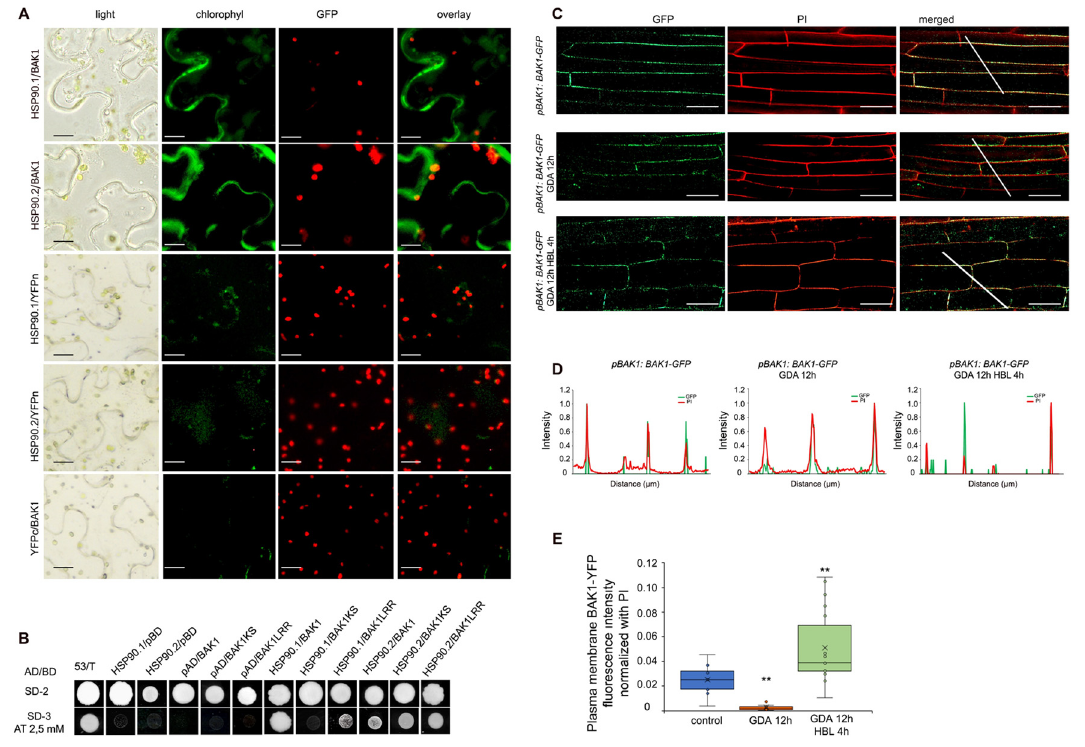
Figure 4. HSP90 physically interacts with the BAK1 co-receptor and modulates its abundance at the plasma membrane. ( A ) BiFC interaction assays of HSP90.1 or HSP90.2 with BAK1 in N. benthamiana leaf epidermal cells. Scale bars, 20 µ m. ( B ) Yeast two-hybrid assays using full-length BAK1, BAK1LRR, or BAK1KS as baits and HSPSP90.1 or HSP90.2 as preys. Upper column, co-transformants grown on